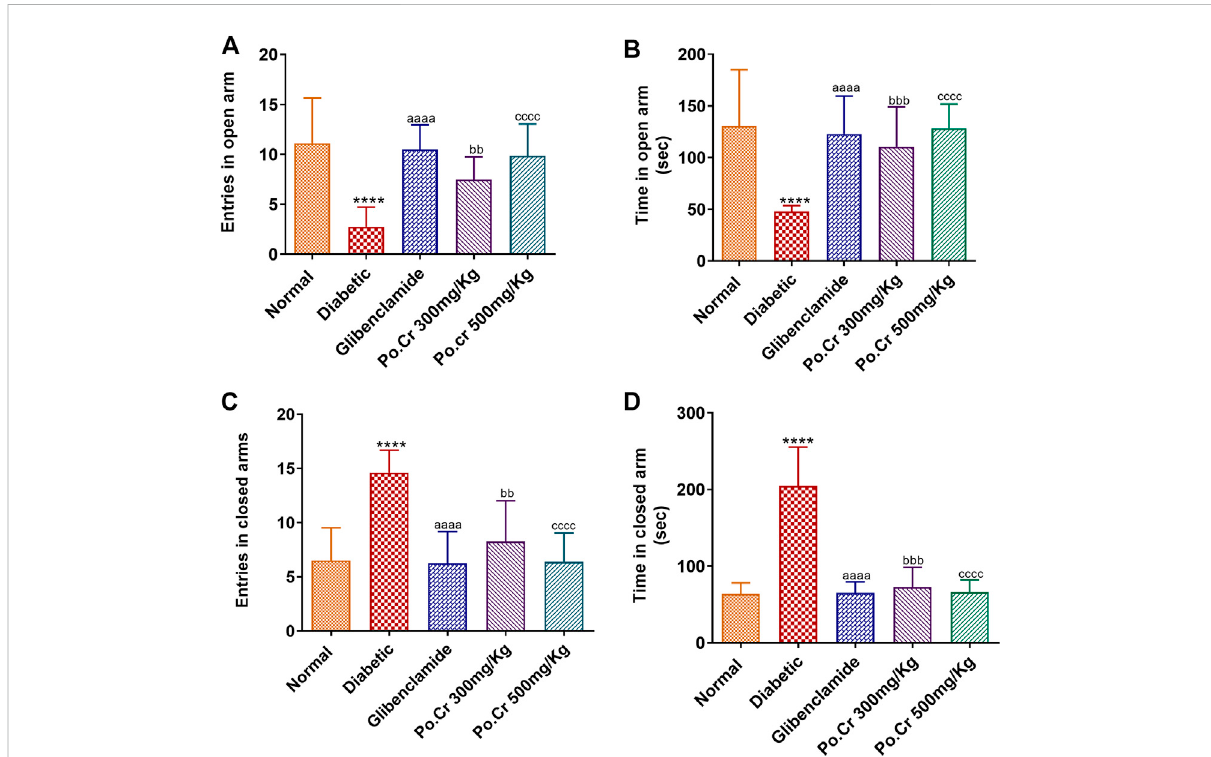
FIGURE 4 AnxiolyticeffectsofPo.Crintheelevatedplusmaze(EPM)testofalloxan-induceddiabeticrats. (A) Entriesintoopenarm. (B) Timespentinopen arm. (C) Entries into closed arm. (D) Time spent in closed arm. Group II (diabetic control) was compared to Group I (normal control), whereas all the treated groups (Groups III [glibenclamide] to V [Po.Cr]) were compared with Group II (diabetic control). ANOVA (two-way) and the multiple comparison Dunnett ’ s test were applied, and the data values are mean ± SEM. * p < 0.05 indicates comparison of diabetic control (Group II) to normalcontrol(GroupI),whereas a p < 0.05, b p < 0.05, and c p < 0.05indicatescomparisonofglibenclamide(GroupIII);Po.Cr,300 mg/kg(GroupIV); and Po.Cr, 500 mg/kg (Group V) versus the diabetic control group,